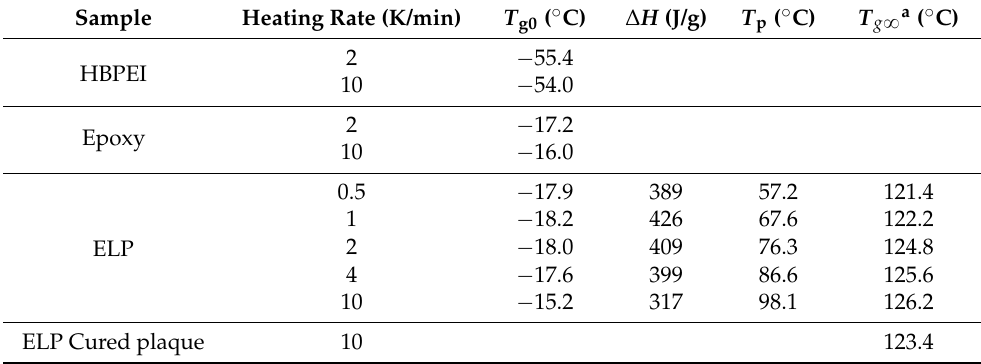
Table 2. Differential scanning calorimetry (DSC) results for the HBPEI, epoxy and ELP